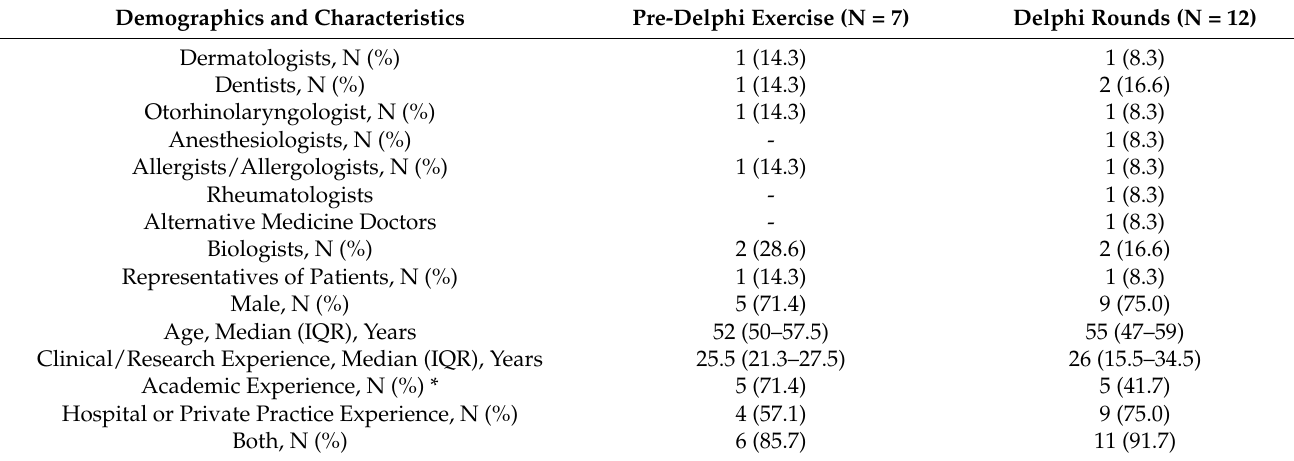
Table 2. Characteristics of the members in the pre-Delphi and Delphi consensus